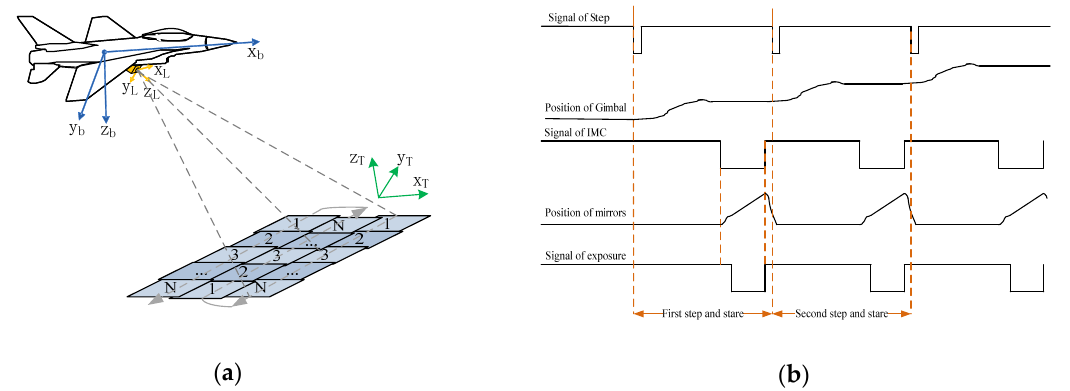
Figure 2. Working principle and timing diagram; ( a ) working principle; ( b ) timing diagram.